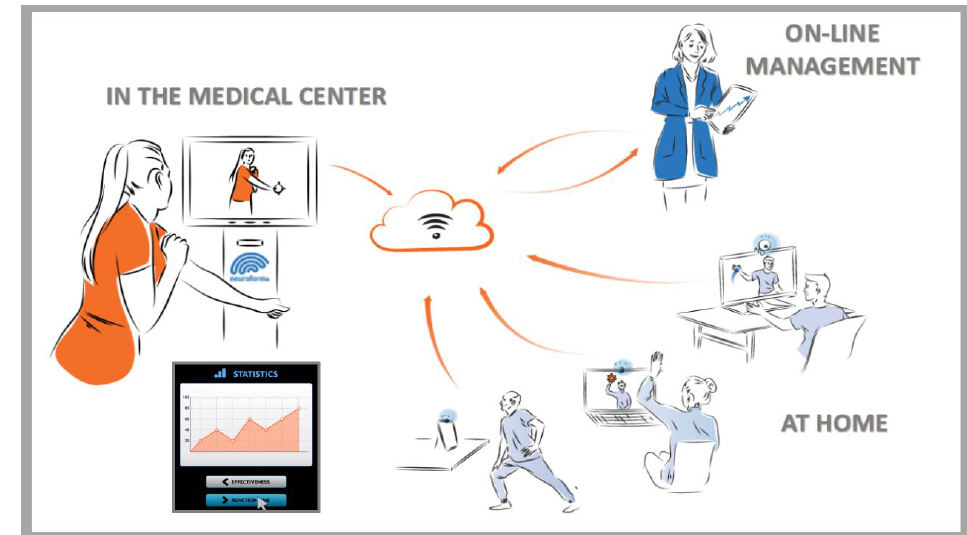
Figure 1. The illustration of basic applications of innovative IT/ICT technologies, e.g., for the VR NEUROFORMA system, which is used in our laboratory: use in stationary settings such as research/medical centers or hospitals, remotely via mobile devices such as iPhones and tables, or using PCs at home (materials from our lab repository, with permission of the Titanis Ltd.).